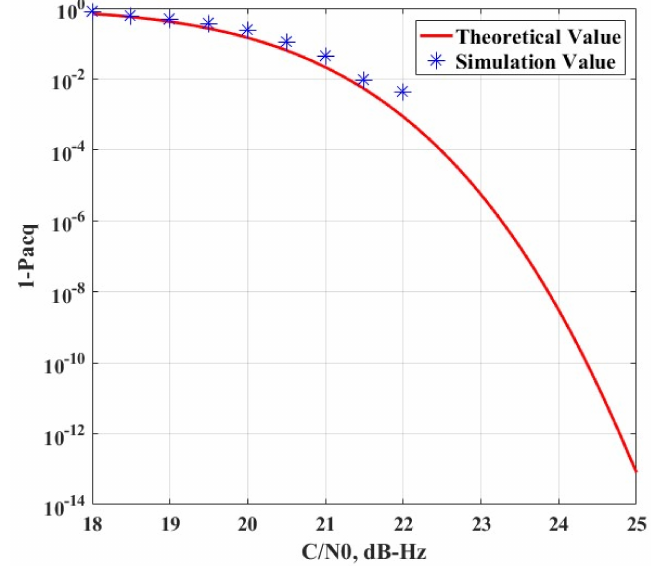
Figure 8. Comparisons of carrier acquisition probability between theoretical prediction and